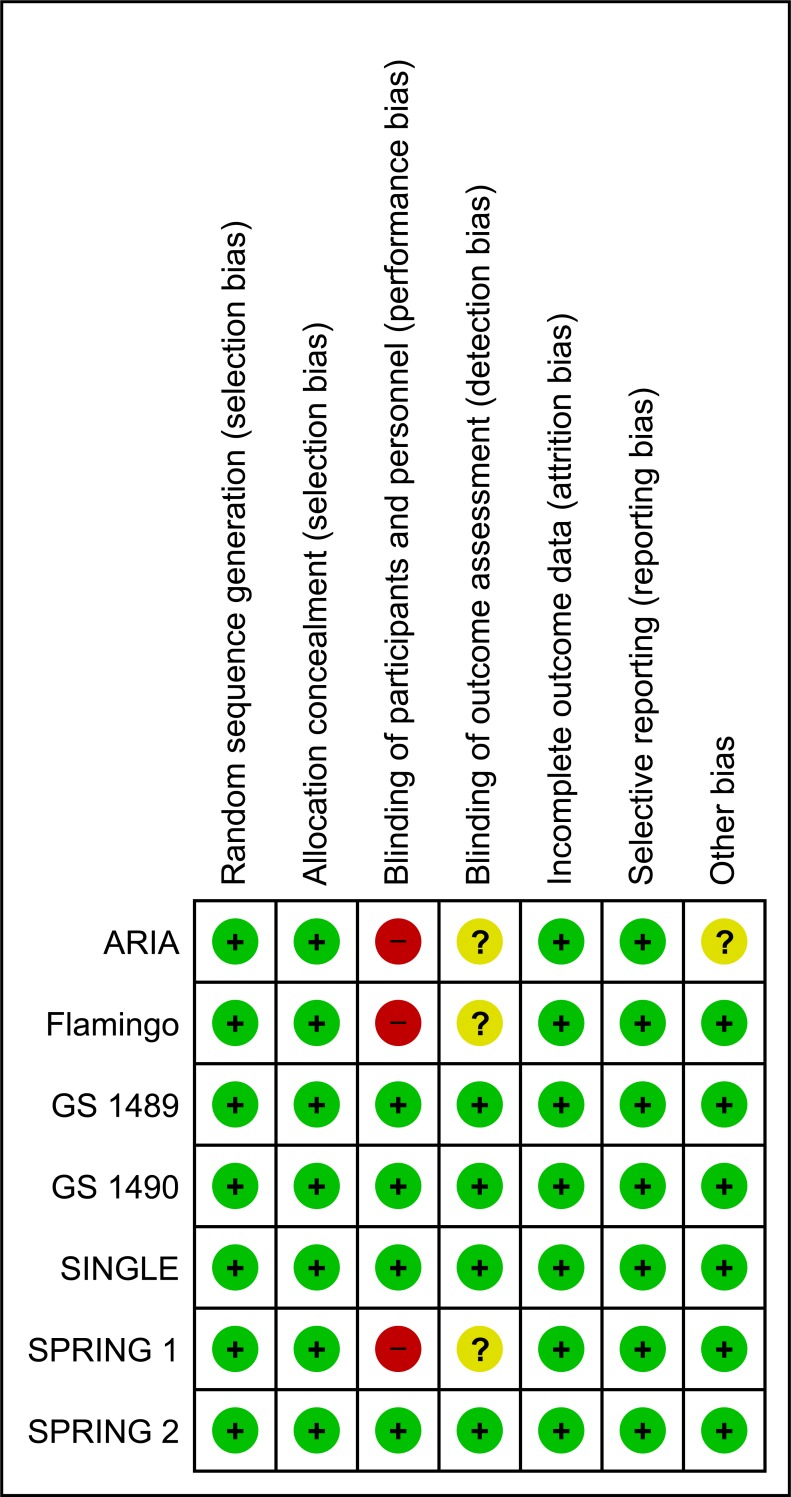
Risk of bias summary: Review authors’ judgment about each risk of bias item for each included included study.